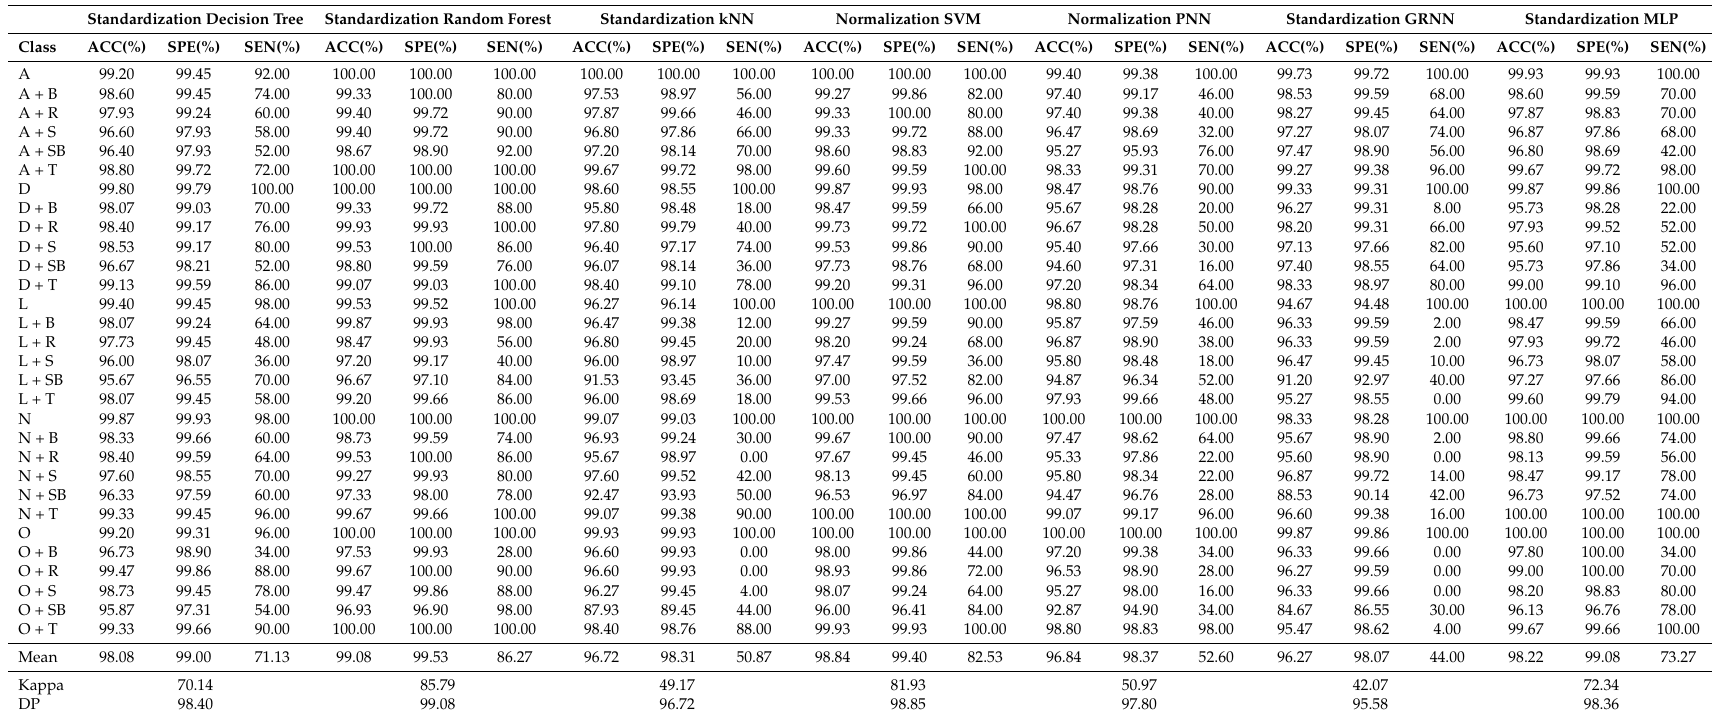
Table 5. Results of classification per